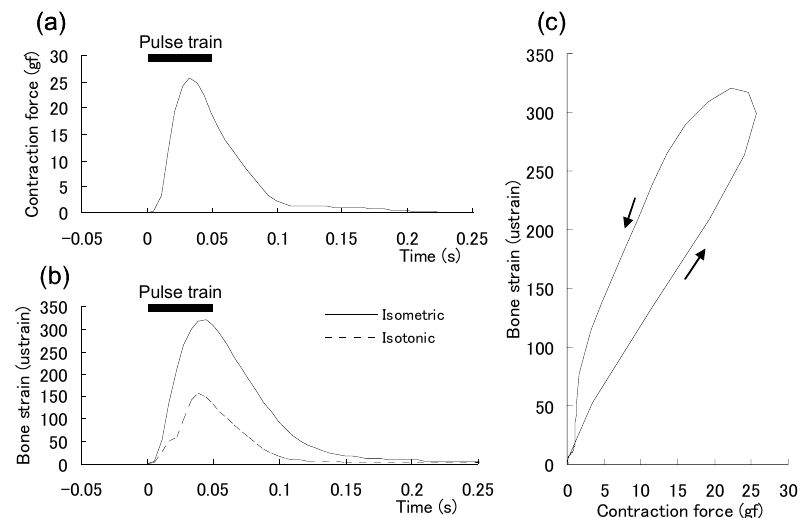
Fig. 4 Waveforms of muscle contraction force (a) and bone strain (b) on the anterior surface at the femur midshaft, induced by giving one pulse train (PT) with a magnitude of +2.0 mA for 50 ms to a rat quadriceps. (c) The relationship between quasi-isometric contraction force and bone strain. The data represents averaged values of five